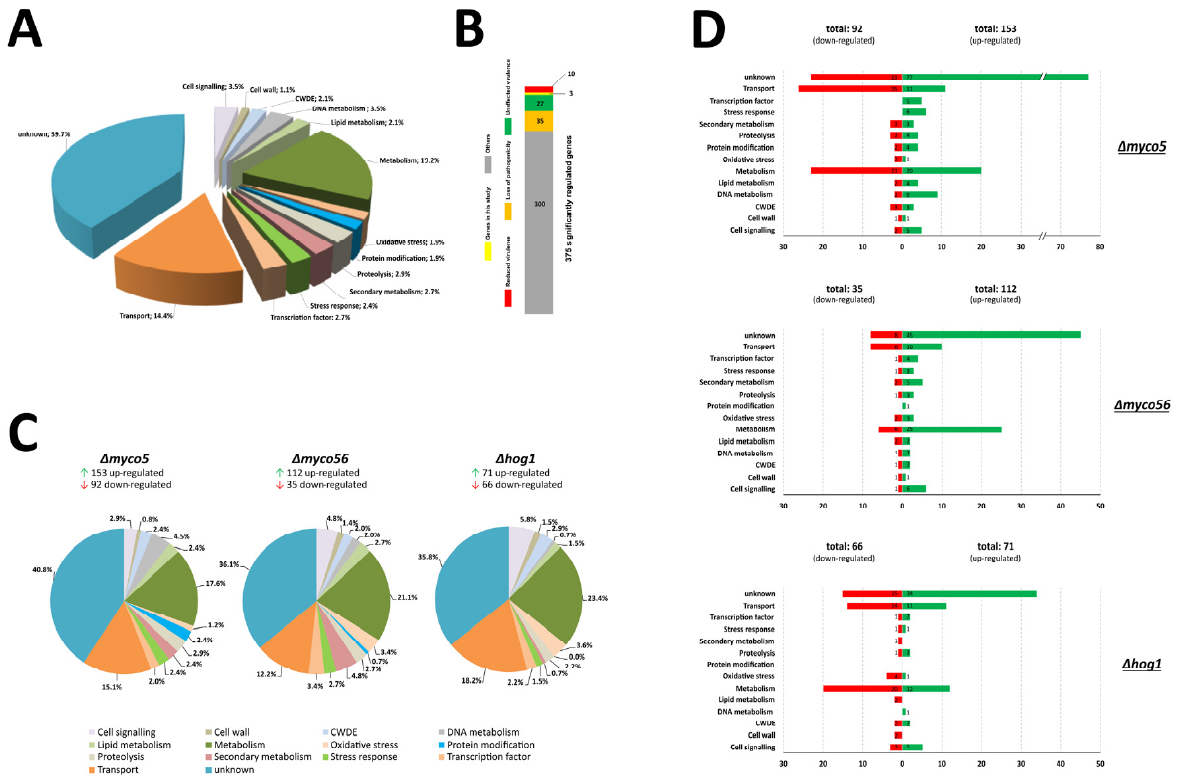
Figure 3. Transcriptome analysis of the strains IPO323, ∆ myco5 , ∆ myco56 and ∆ Zthog1 grown under the dimorphic switch inducing condition. ( A ) Pie chart showing the custom categories of the products of all the DE genes (375) obtained from RNA-Seq analysis that were categorized by using data obtained from JGI server and Blast2GO analysis. Significant differential expression was defined as average expression altered by a factor >2.5 × at one instance of pairwise compar- isons across all the strains investigated and with a q-value threshold of less than or equal to 0.05. ( B ) Identification of virulence genes. Searches using the predicted amino acid sequences from the set of DE genes was undertaken by using BLASTp (E-value cutoff of ≤ 10 − 30 ) against the PHI-Base database (version 4.1) to assess potential involvement in host–pathogen interaction. ( C ) Pie charts showing the biological categories of all the DE genes obtained from the RNA-Seq studies. The pie chart shows the percentage of the genes expressed for each biological process. Biological categories were assigned manually based on the presence of conserved functional domains, GO annotation and/or the best meaningful match, using BLASTp. Genes identified by using Cuffdiff-analysis were filtered for an absolute fold-change value ≥ 2.5 and q-value threshold of 0.05. ( D ) Functional